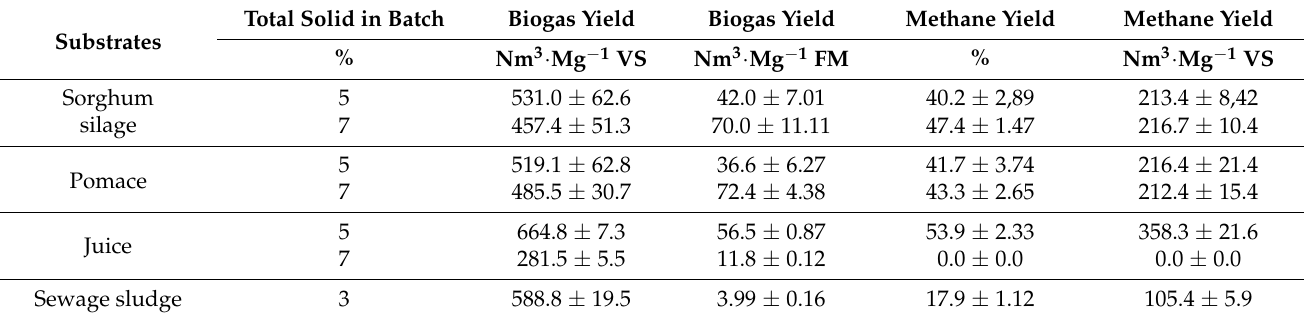
Table 3. Summary of anaerobic digestion results.